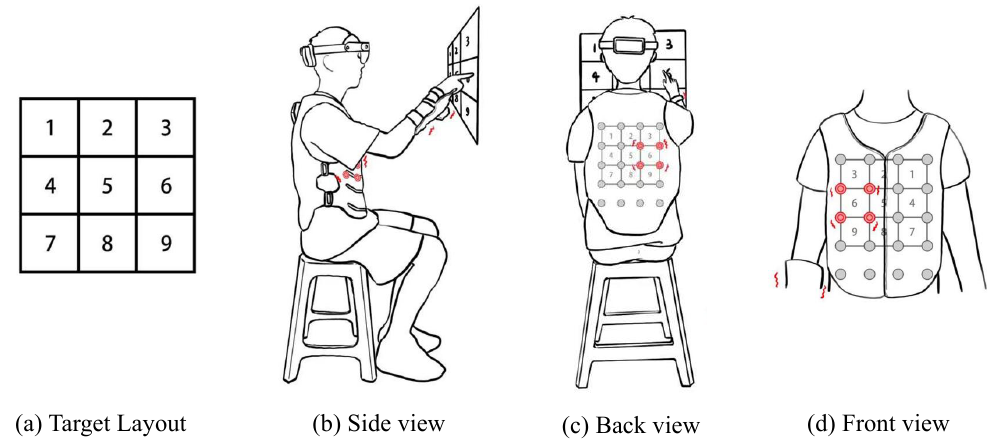
Figure 6. Experimental settings of Study